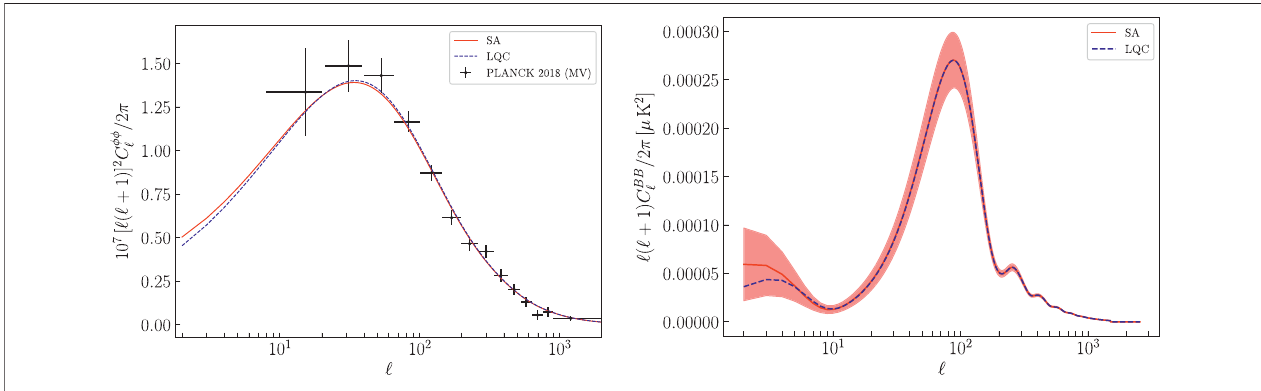
FIGURE 6 | LQC prediction (dashed (blue) line) and the standard ansatz (SA) prediction (solid (red) line). Left Panel: Lensing power spectra. The 2018 PLANCK spectrum(wheretheblackcrossesshowbinninganderrorbars). RightPanel: ThetheoreticalpredictionsfortheBBpowerspectra. ThereispowersuppressioninLQC for very low ℓ . The shaded region shows the 68% con fi dence level